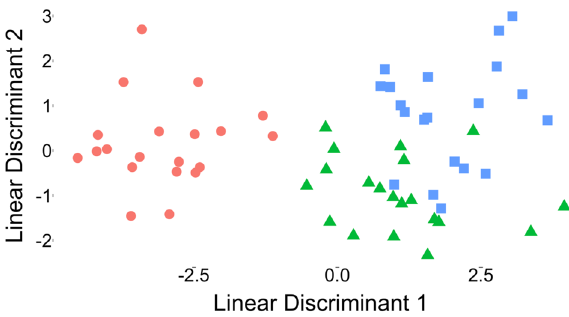
Figure 4. PC-LDA performed on Raman spectra from urine samples inoculated with Escherichia coli (red circle), Enterococcus faecalis (green triangle) and Klebsiella pneumoniae (blue